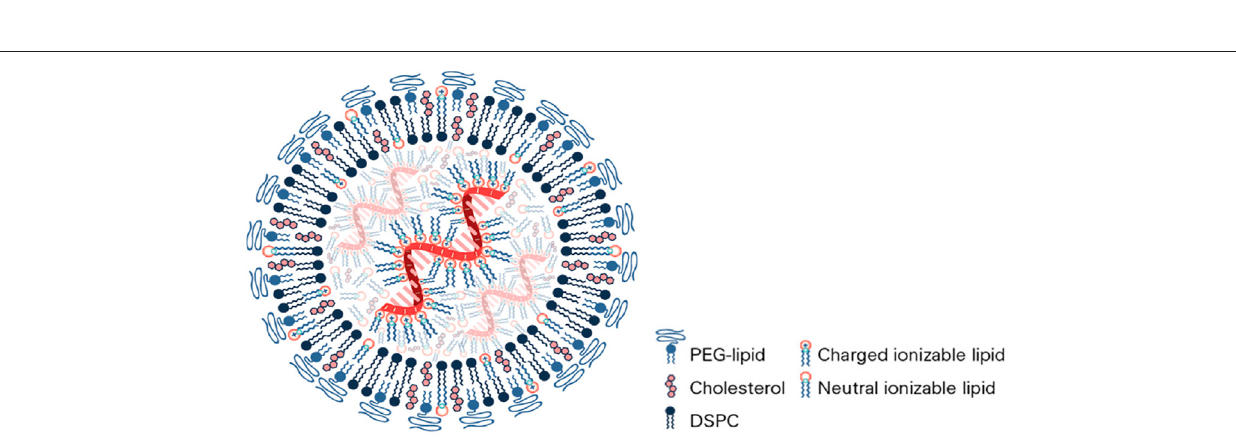
Frontiers in Bioengineering and Biotechnology |